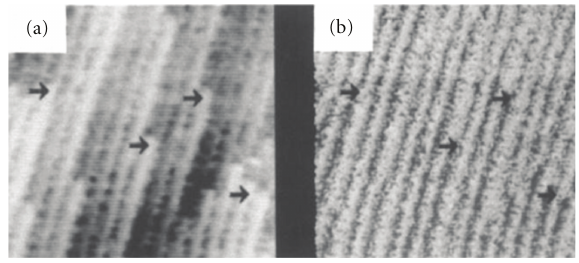
Figure 7: An STM topography of the Au(110)-(1 × 2) (120 × 120 ˚A) and a simultaneously taken light-induced current image [23].